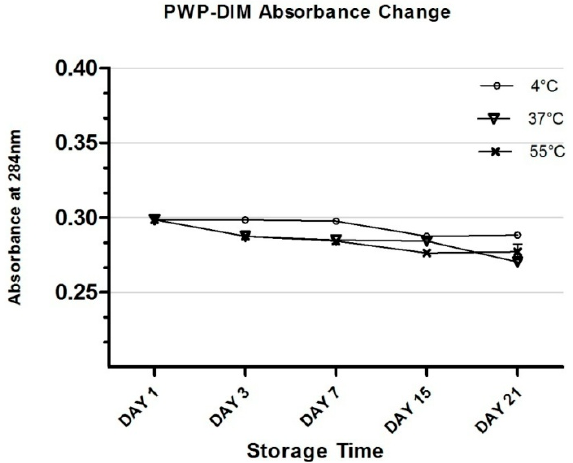
Figure 6. Effect of storage temperature (4, 37 and 55 °C) on the absorbance change of PWP/DIM with mass ratio (5:1) nanoparticles during storage. Values are mean ± SD ( n = 3).